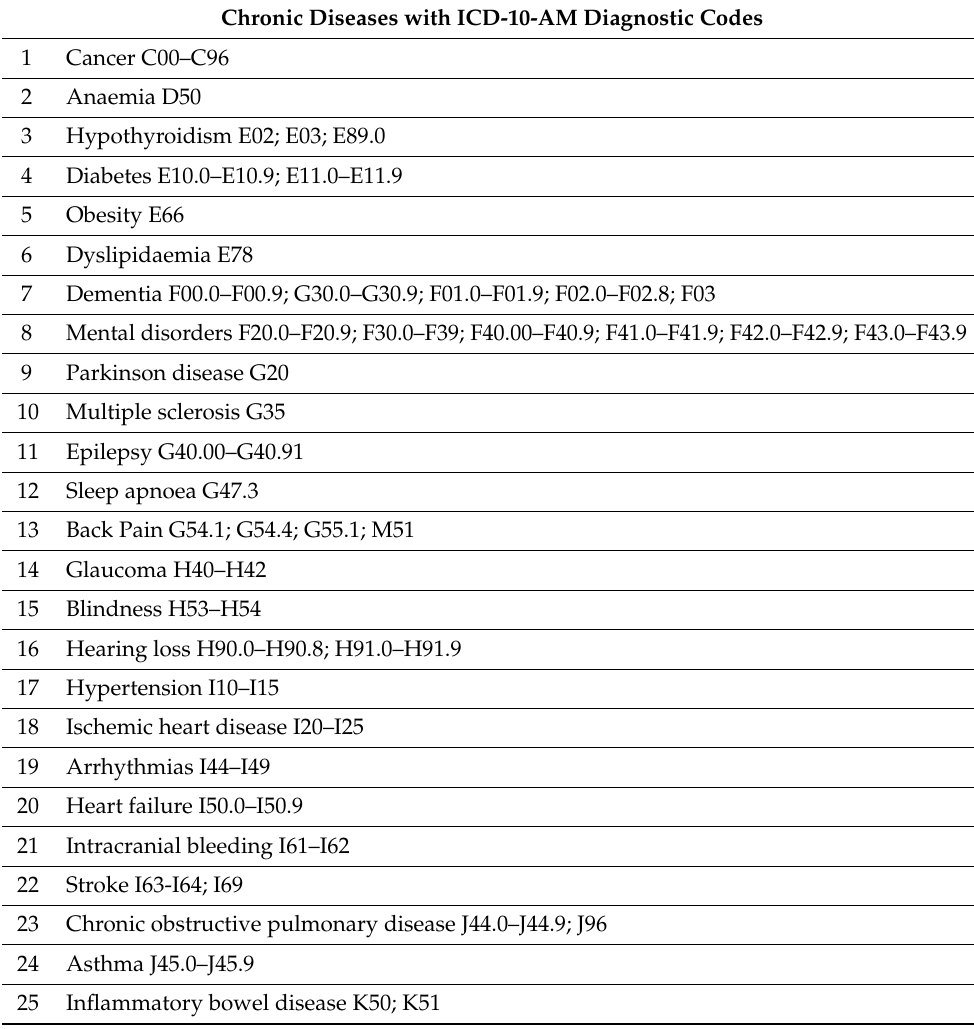
Table 1. The list of the selected chronic diseases associated with ICD-10-AM diagnostic